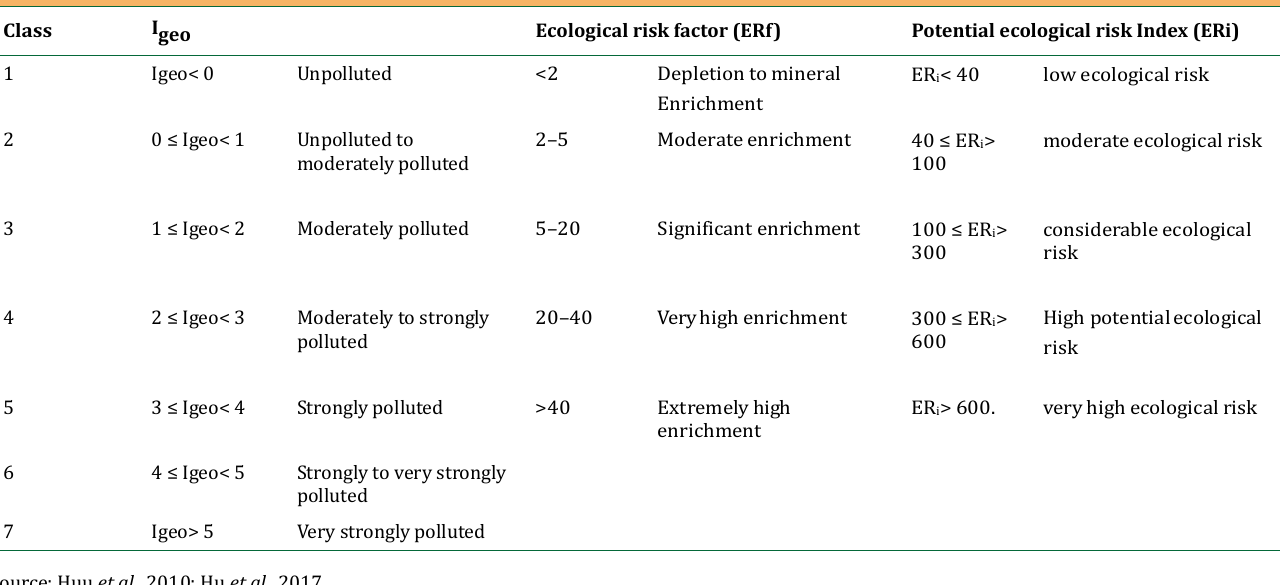
Table 7: Classification of Geoaccumulation Index and Ecological Risk